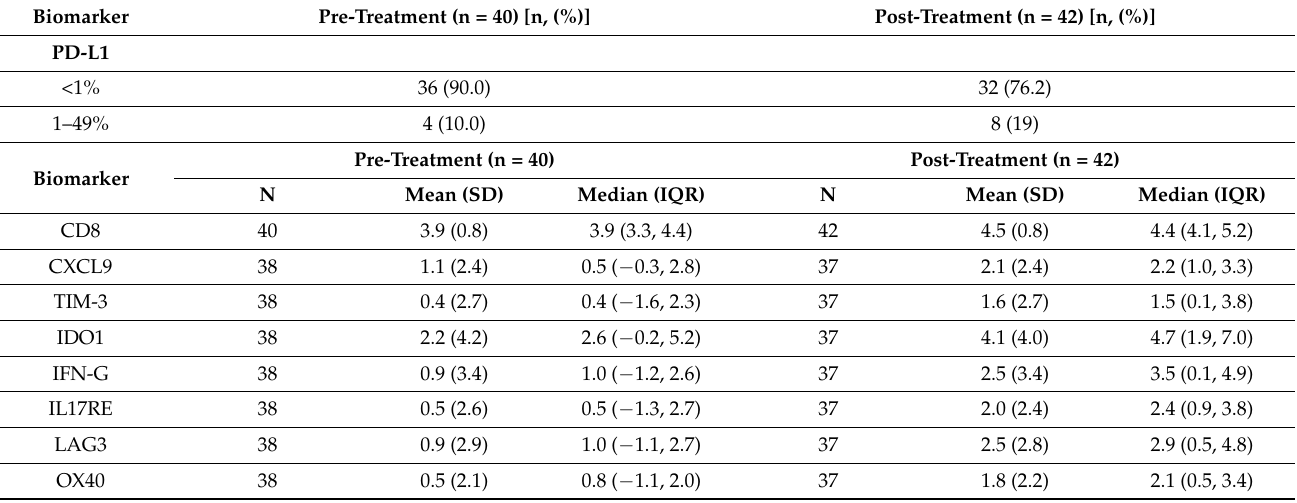
Table 1. Summary for rectal cancer biomarkers by time